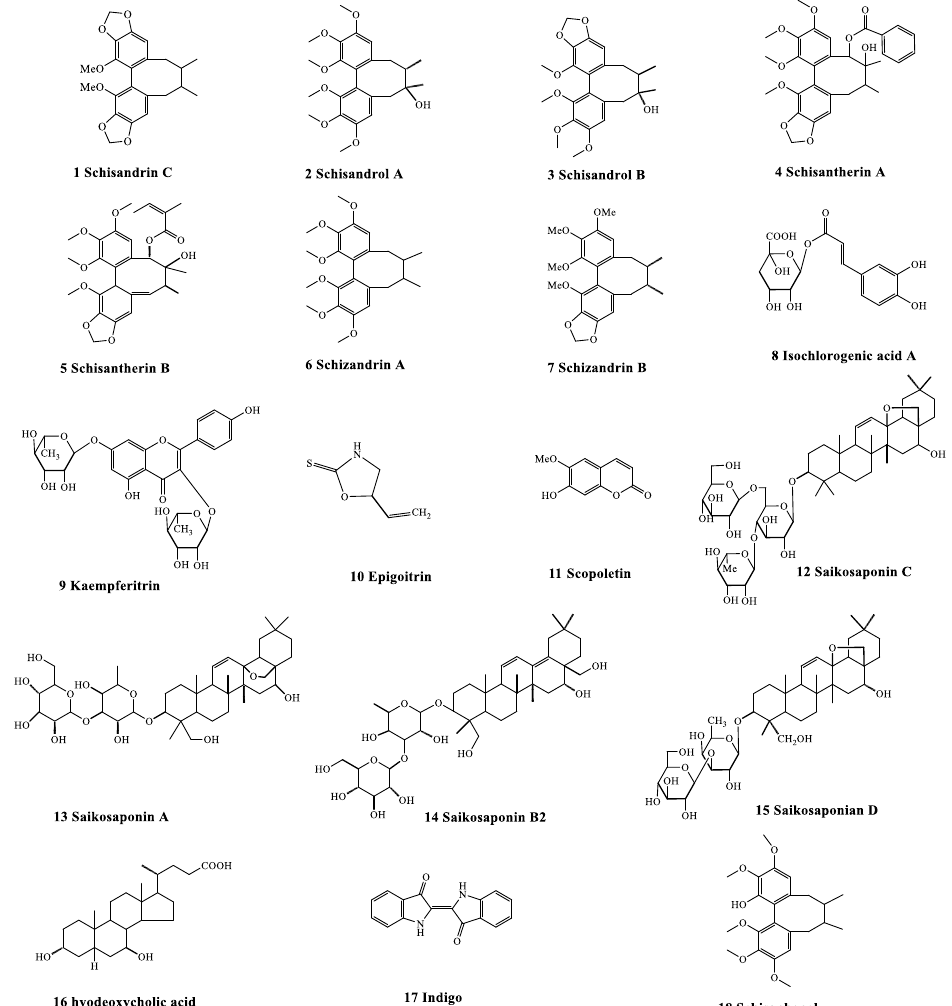
Figure 1. The structures of 18 reference standards in Hu Gan tablets.